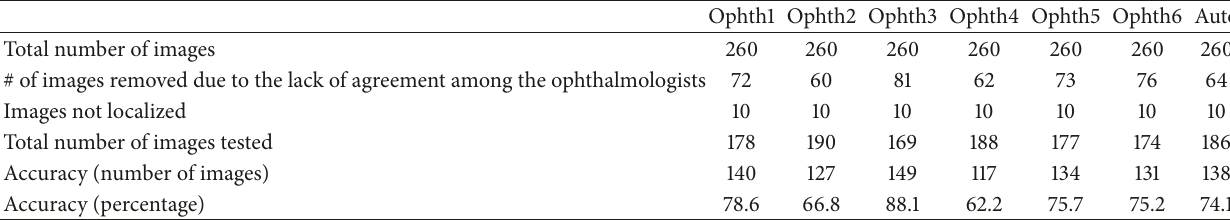
Table 9: The VCDR results for MESSIDOR images